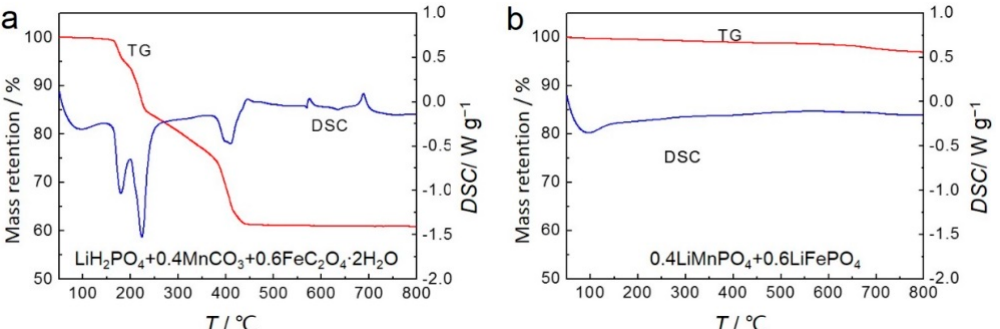
Figure 9. TG-DSC analyses of reaction process of synthesizing LiMn 0.4 Fe 0.6 PO 4 : ( a ) conventional solid-state reaction; ( b ) calcination through precursor nano-plates.